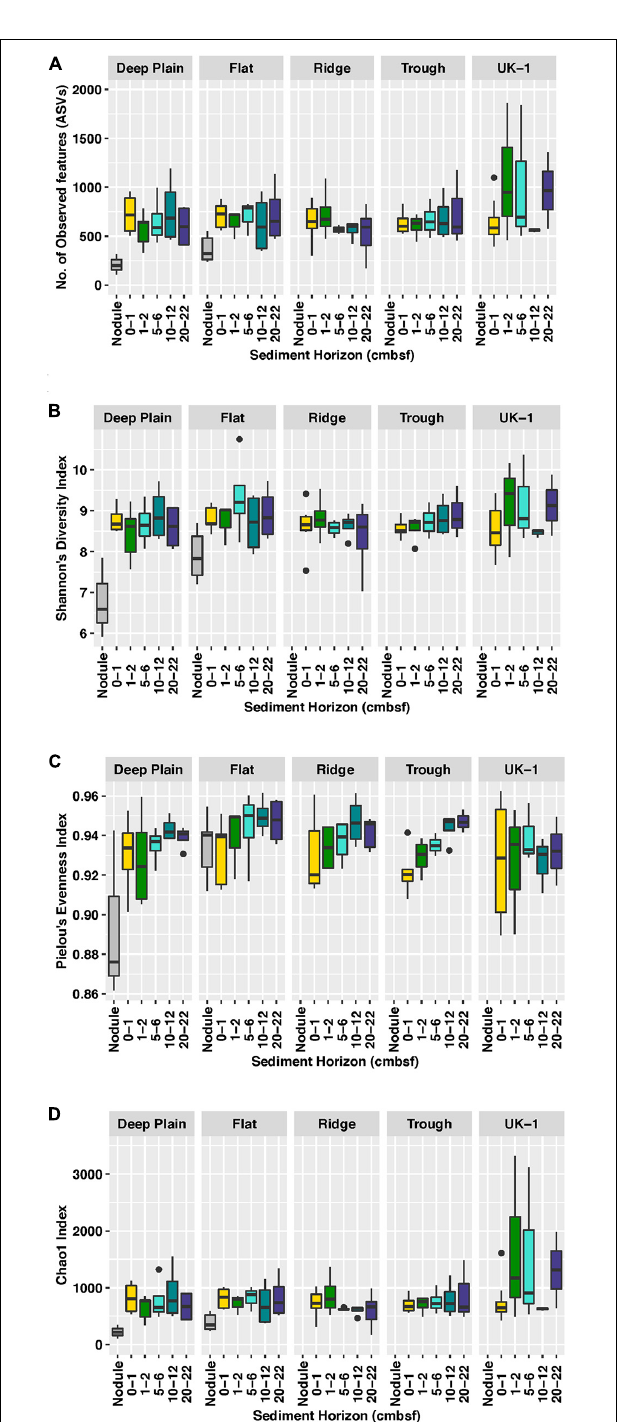
FIGURE 2 | Comparisons of diversity indices between sediment and nodule-associated microbial communities, at APEI-6 and UK-1, based on (A) Number of observed features or amplicon sequence variants (ASVs), (B) Shannon’s Diversity Index, (C) Pielou’s Evenness Index, and (D) Chao1 richness Index. Boxplots show the median (horizontal line), interquartile ranges (box limits), range (whiskers), and outliers (black dots). Diversity indices were calculated on samples that had been rarefied to account for uneven sampling